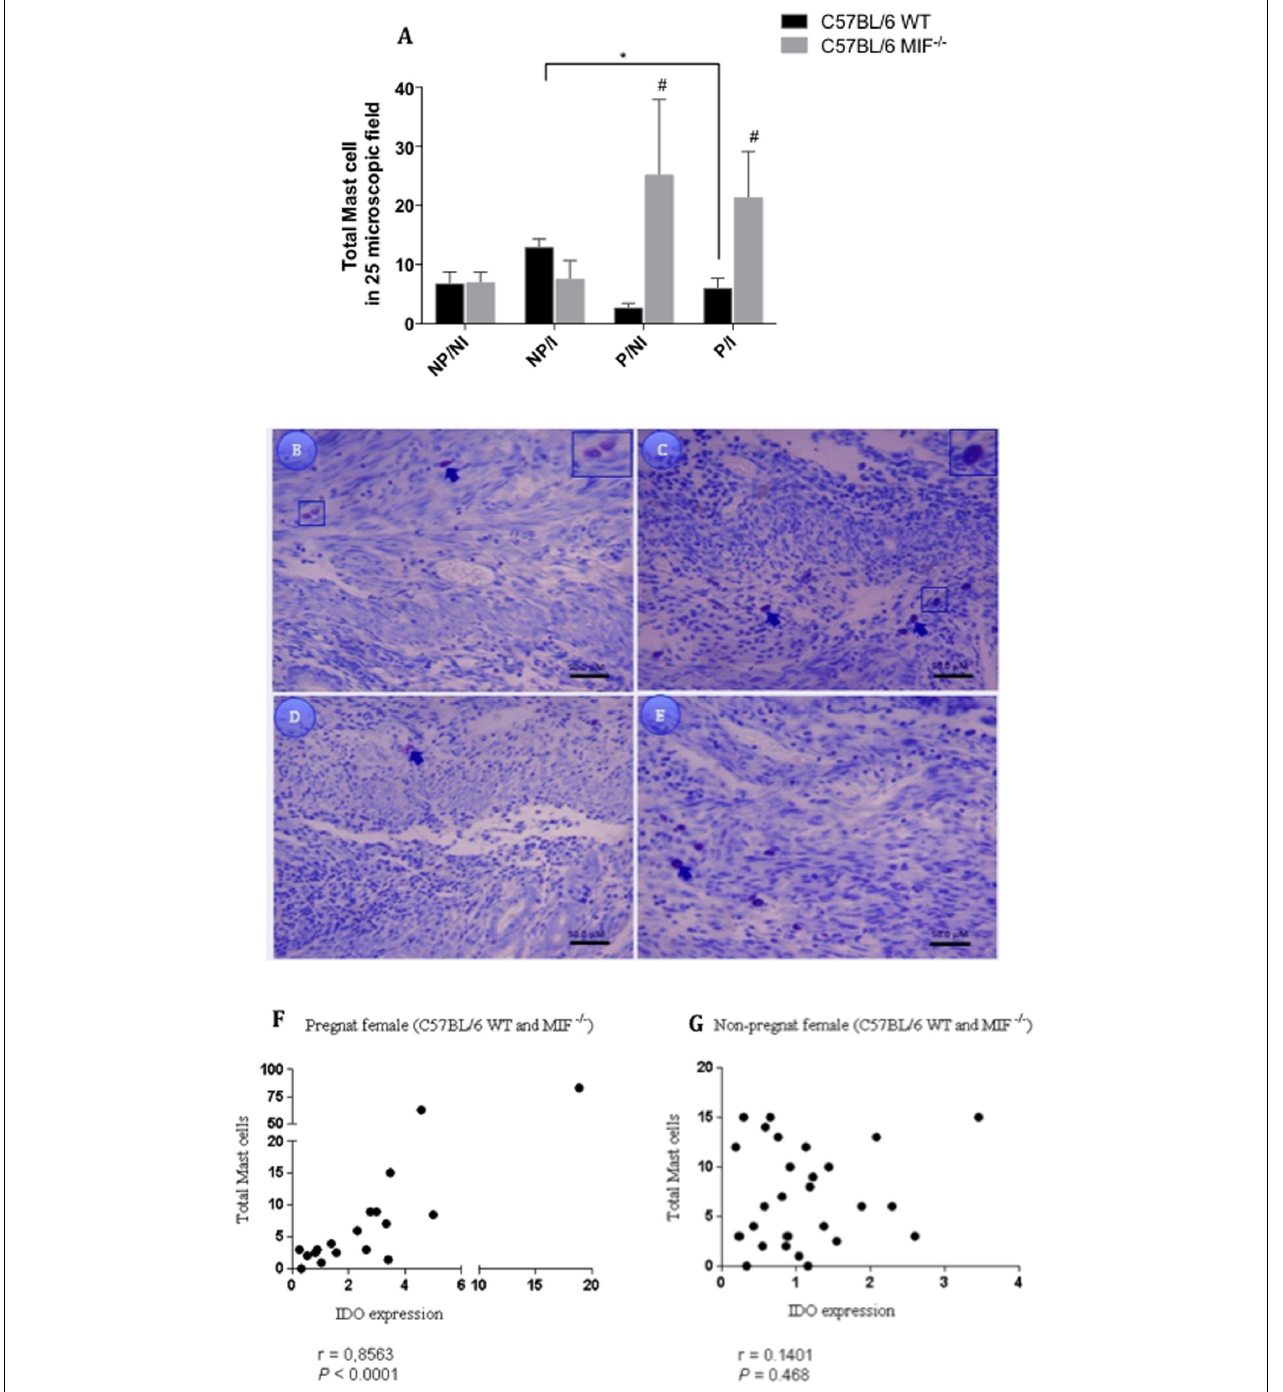
FIGURE 6 | (A) Mast cell (MC) quantification in uterus/implantation sites from non-pregnant and pregnant females of C57BL/6 MIF − / − and C57BL/6 WT mice infected or not by Toxoplasma gondii ( n = 5 animals per group). Paraffin-embedded 4- µ m tissue sections were stained with toluidine blue for MC quantification. MCs were counted in 25-microscopic fields per tissue section, and each animal was analyzed in two tissue sections. # Significant differences between MIF − / − and WT mice in the same experimental condition ( # P < 0.05). ∗ Comparisons between multiple experimental conditions within the same group (NP/NI, non-pregnant/non-infected; NP/I, non-pregnant/infected; P/NI, pregnant/non-infected; P/I, pregnant/infected) are indicated by bars ( ∗ P < 0.05). Data were compared by the Kruskal–Wallis test and Dunn’s multiple comparison post-test. (B–E) Representative images from uterus tissues of pregnant/non-infected WT (B) and MIF − / − (C) females; and pregnant/infected WT (D) and MIF − / − (E) females. Arrows indicate granulated and degranulated MCs. Bar scale = 50 µ M. Correlation between IDO expression and total MCs counted in the uterus of pregnant (F) and non-pregnant (G) C57BL/6 MIF − / − and WT females.